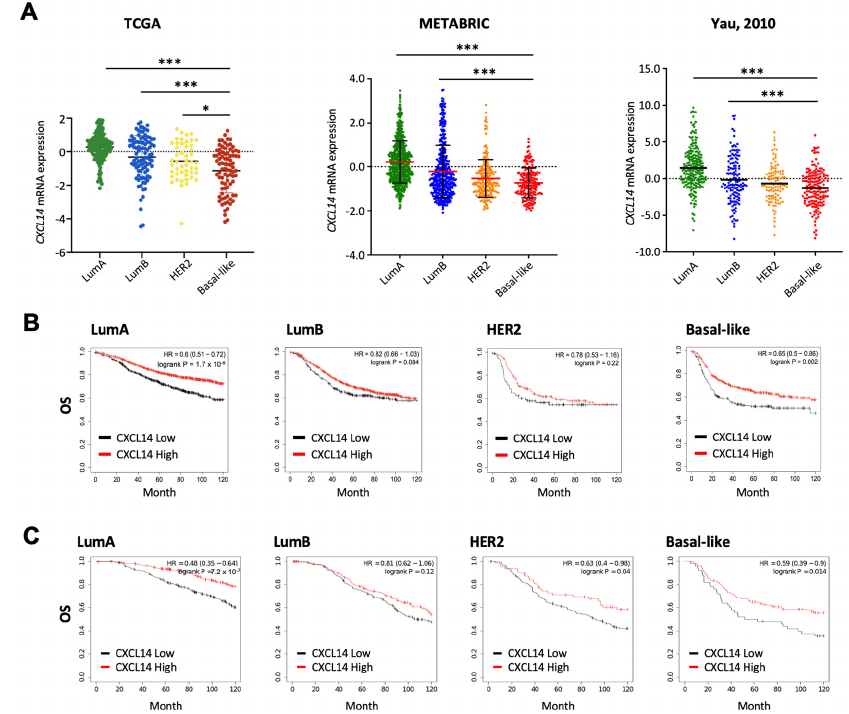
Figure 2. CXCL14 expression levels and its correlation with survivals in breast-cancer subtypes. ( A ) Comparison of CXCL14 expression levels between luminal A (LumA), luminal B (LumB), HER2, and basal-like breast-cancer subtypes in TCGA ( n = 945), METABRIC ( n = 1559), and Yau datasets ( n = 622). ( B , C ) Kaplan–Meier curves for OS between CXCL14-low and -high expression levels in breast-cancer subtypes in the Kaplan–Meier plotter database ( B ) and METABRIC dataset ( C ). Data are presented as mean ± SD. * p < 0.05, *** p < 0.001.